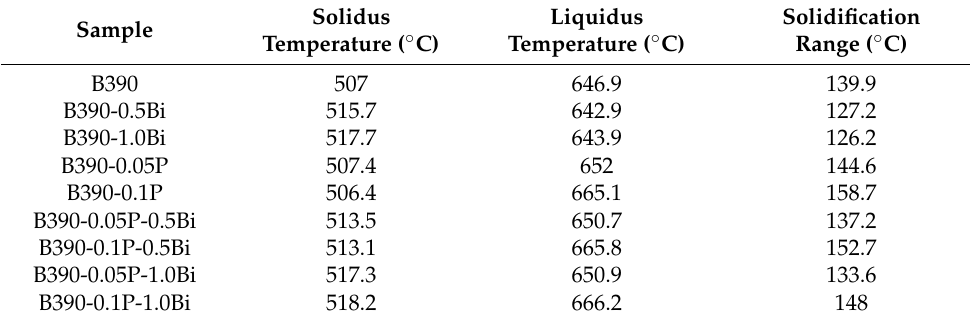
Table 4. Solidification temperature of the unmodified and modified alloys.